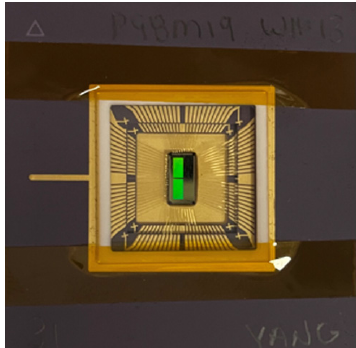
Figure 9. QIS chip.